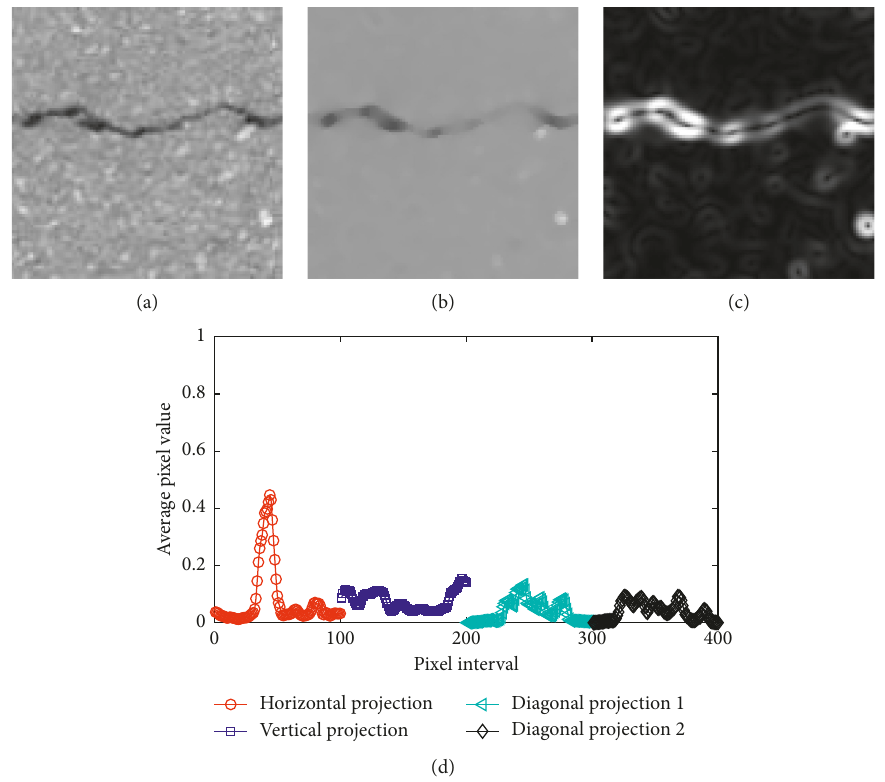
Figure 4: PIs of an image yielded from the STF response. (a) Pavement image. (b) FLLF. (c) STF. (d) Projective integrals.